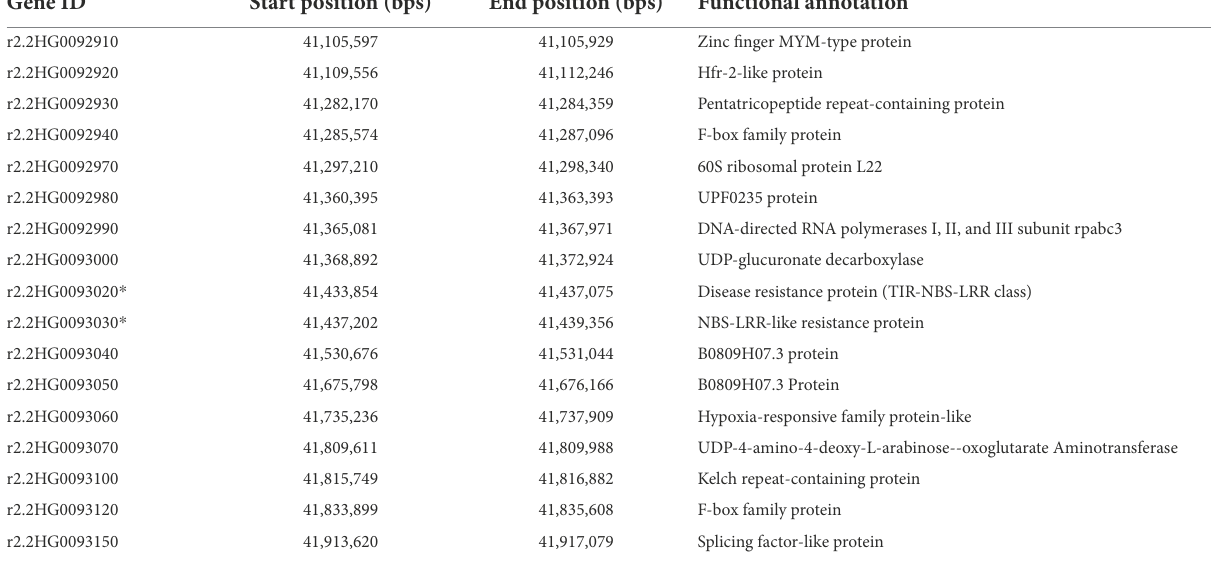
TABLE 6 High confidence genes annotated in the target interval between the flanking markers Mloc-28 and